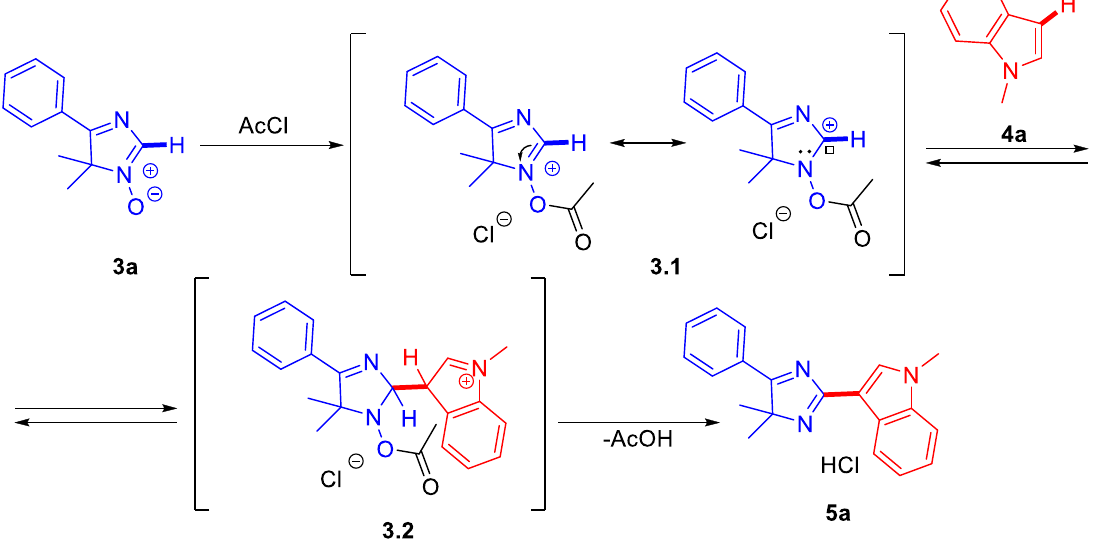
Figure 2. Structures and yields for the obtained indolyl-derived 4 H -imidazoles. (Blue color indicates the imidazole ring, red color shows the indole moiety).